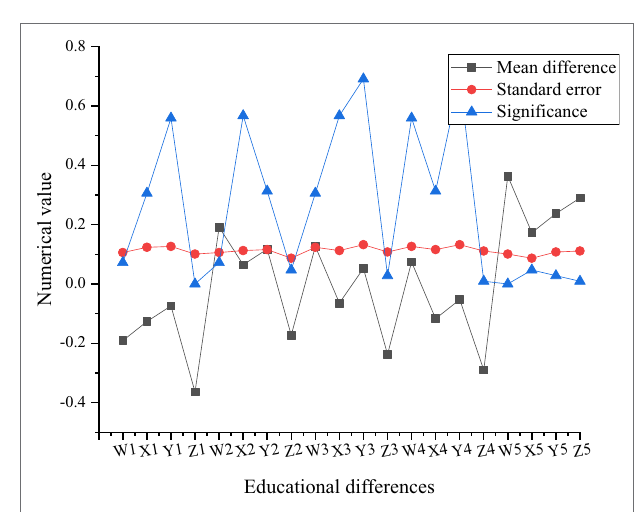
FIGURE 12 | Multiple comparison results of psychological capital of new generation entrepreneurs with different enterprise establishment times (In Figure, W1, X1, Y1, and Z1 are within 1 year of enterprise establishment, W2, X2, Y2, and Z2 are 1–3 years of enterprise establishment, W3, X3, Y3, and Z3 are 3–5 years of enterprise establishment, and W4, X4, Y4, and Z4 are 5–10 years of enterprise establishment,